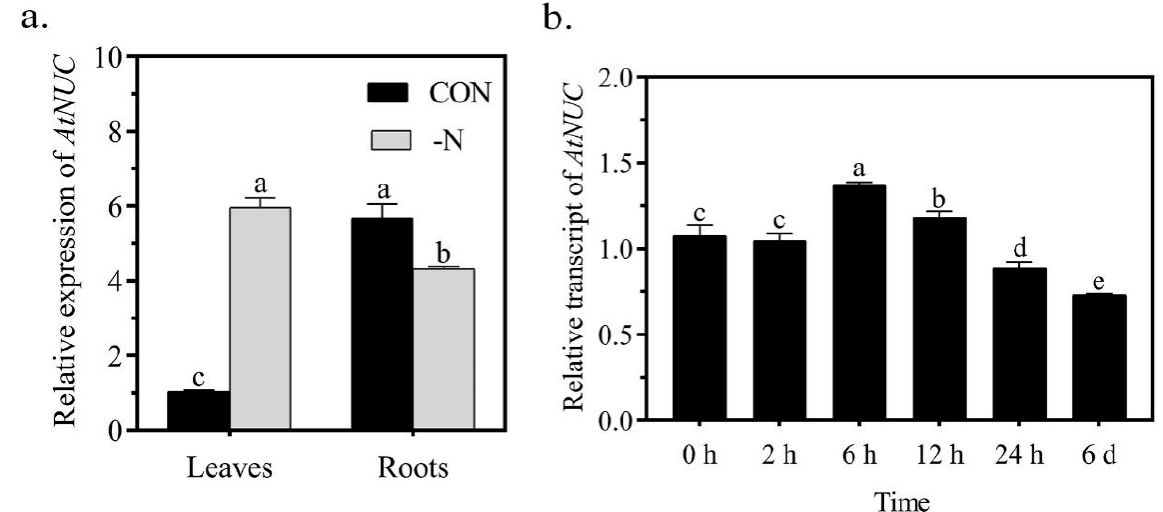
Figure 3. Expression of AtNUC in response to N deficiency. ( a ): Expression of AtNUC in leaves and roots under N deficiency for 6 days. ( b ): Expression of AtNUC in roots under N deficiency in a time course. Values are the means ± SDs ( n = 3). Different letters indicate significant difference between treatments according to Duncan’s multiple range test at p < 0.05.